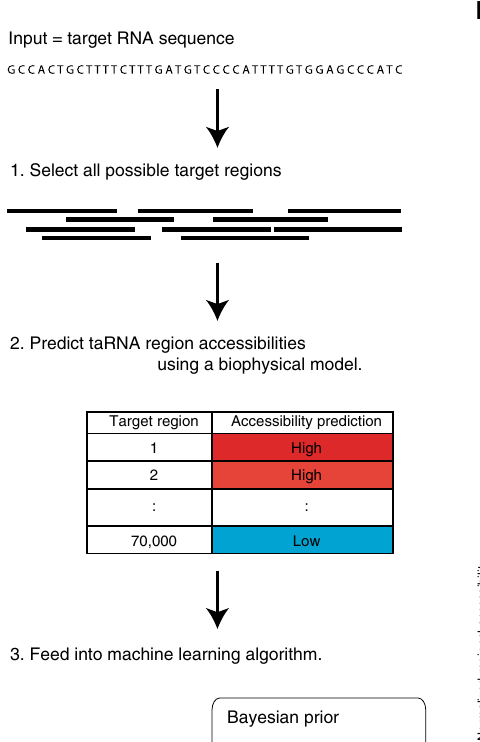
3. Feed into machine learning algorithm.